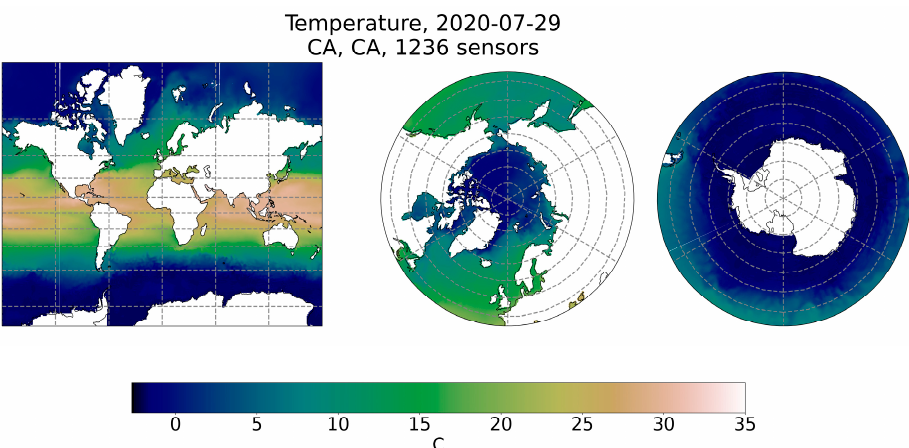
Figure 8. Reconstructed field by the Concrete Autoencoder (CA) from 1236 sensors.